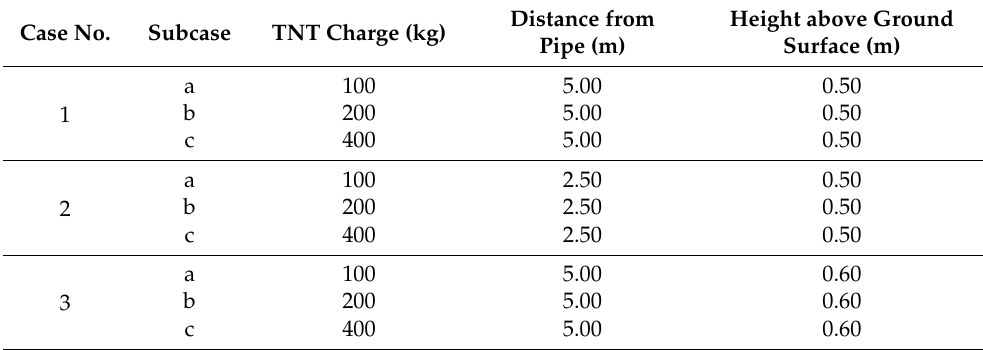
Table 4. The case studies considered in the finite element analyses, with and without the meta ‐ material layout.